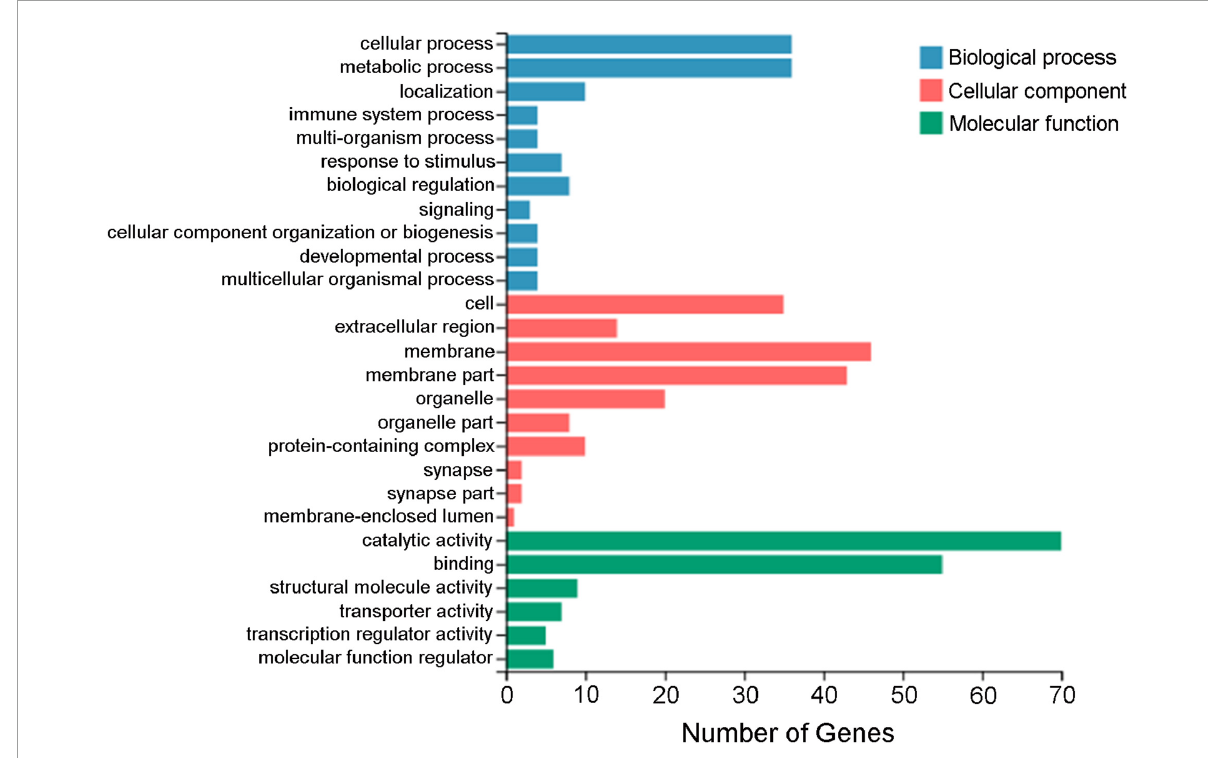
FIGURE7 GO annotation of the differentially expressed genes. The x -axis indicates the number of genes, and the y -axis indicates the subcategories.